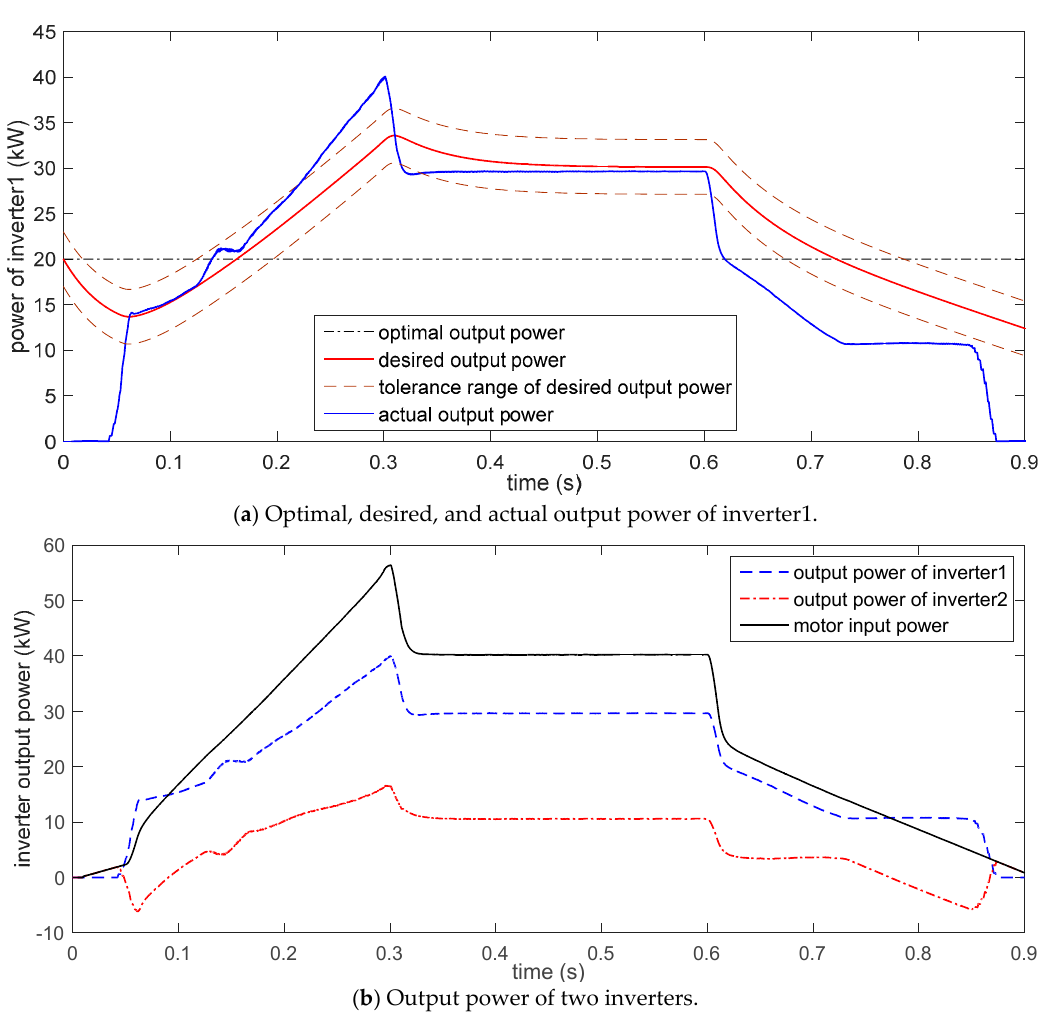
Figure 14. Curves of inverter output power.